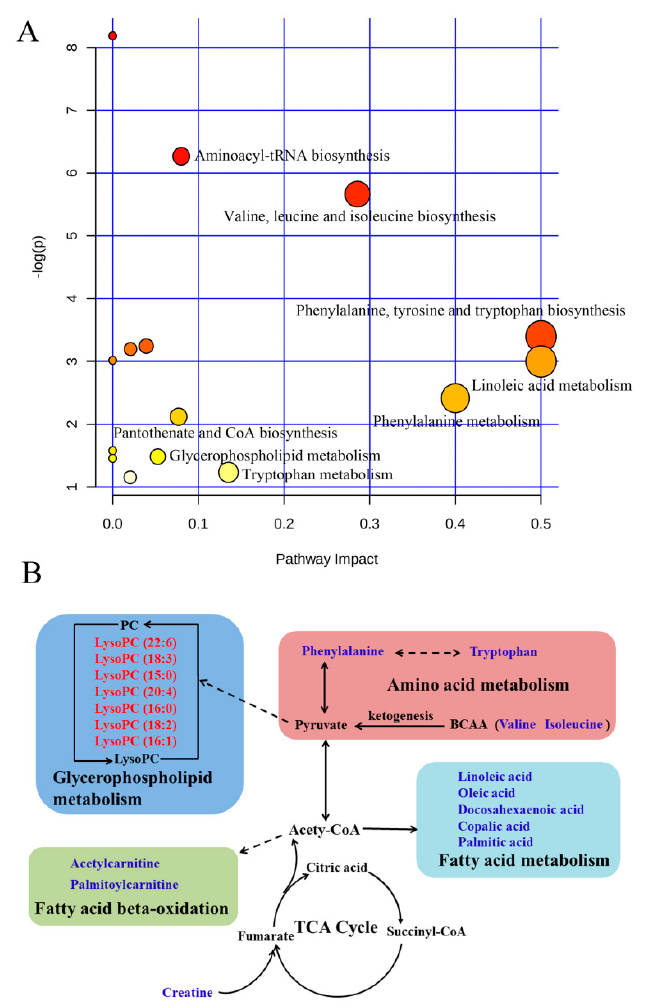
Figure 4. Disturbed pathways in response to blood stasis and AEE treatment. ( A ) Summary of pathway analysis from MetaboAnalyst. All of the matched pathways are displayed as circles. The color and size of each circle are based on its -log (p) value and pathway impact value, respectively. The x-axis represents the pathway impact value that was calculated from the pathway topological analysis, and the y-axis represents the -log (p) value that was obtained from the pathway enrichment analysis. The metabolic pathway with a high pathway impact value and -log (p) value shows that the identified metabolites had a key position and influence on this pathway. ( B ) The potential metabolic network that was disrupted in rats with blood stasis and was altered by AEE treatment.